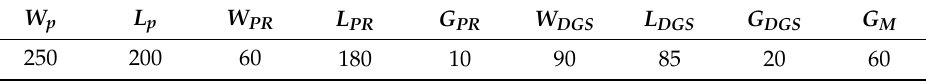
Figure 2. Proposed patch antenna with defected ground structure (DGS). Table 1. Dimensions of designed patch antenna with DGS at 300 GHz (in μ m).